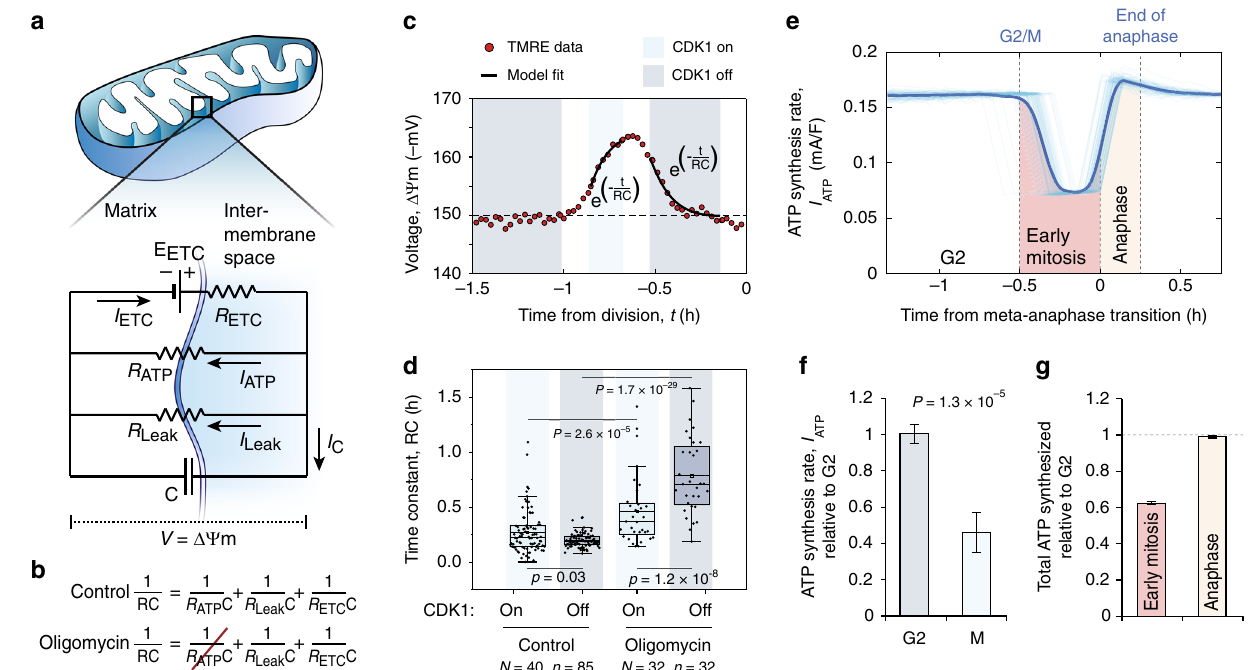
Fig. 4 Electrical circuit model reveals decreased mitochondrial ATP synthesis in early mitosis. a , b Electrical circuit model of mitochondria, where Δ Ψ m is the voltage across the circuit ( a ). The key components controlling Δ Ψ m (ETC, ATP synthase, and leakage), all have their respective resistances ( R ETC , R R R ) in the circuit ( b ). Oligomycin increases the R fi nity. The difference in R values ATP , and Leak ), which together form the total resistance ( ATP value to in between control and oligomycin-treated cells re fl ects the R ATP value. c Model fi t to a typical L1210 single-cell TMRE data. TMRE signals were converted to approximate voltages and CDK1 on (light blue) and CDK1 off (dark blue) regions were fi tted separately to derive the time constant (RC) values for each state. d Time constant (RC) values for CDK1 on (light blue) and CDK1 off (dark blue) regions in control and 1 µ M oligomycin-treated L1210 cells. Data depict the mean (small square), median (horizontal bar), interquartile range (IQR) (box), and 1.5× IQR (whiskers). Statistical signi fi cance was assessed using one-way ANOVA followed by Sidakholm test. N denotes the number of independent experiments, n denotes the number of cells. e ATP synthesis rate ( I ATP ) for 85 separate L1210 cells around cell division. Individual cells are drawn with thin opaque lines; the population average is drawn with a thick solid line. The colored areas re fl ect total amounts of ATP synthesized during early mitosis (red) and anaphase (light yellow). f Quanti fi cations of relative ATP synthesis rates ( I ATP ) in G2 (dark blue) and mitosis (light blue) as modeled on a single-cell level in non-arrested cells. G2 rates were obtained using RC values for CDK1 off, and the Δ Ψ m observed prior to mitotic entry. Unpaired, two-tailed Student ’ s t test was used for statistical analysis. g Quanti fi cations of the total ATP synthesized by mitochondria during early mitosis (from G2/M to M/A transition, red) and during anaphase (light yellow), when compared to a null- hypothesis where ATP synthesis rate remains at G2 levels throughout mitosis (dashed horizontal line). For panels ( f , g ), data depict mean ± SEM (see Supplementary Note 8 for error analysis), and the data are the same as in panel ( d